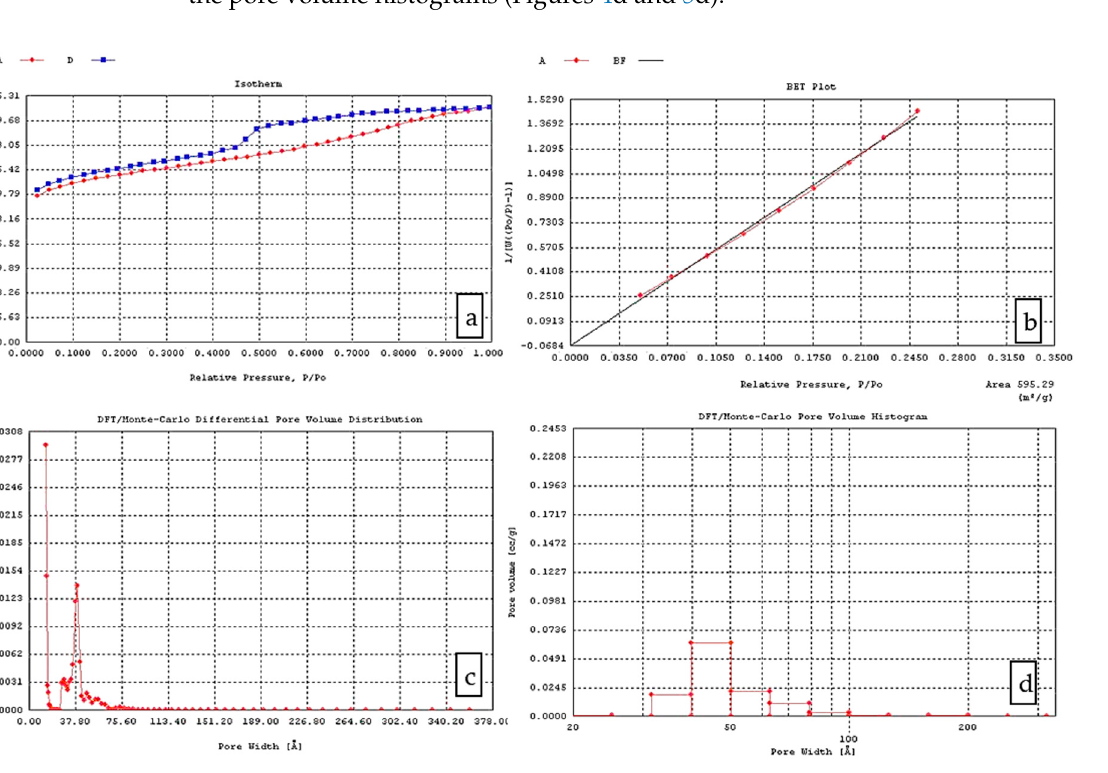
Figure 4. CX Variant X2 (after gel impregnation in the carbon felt and pyrolysis): ( a ) Adsorption isotherm; ( b ) BET plot; ( c ) Pore volume distribution; ( d ) Pore volume histogram.